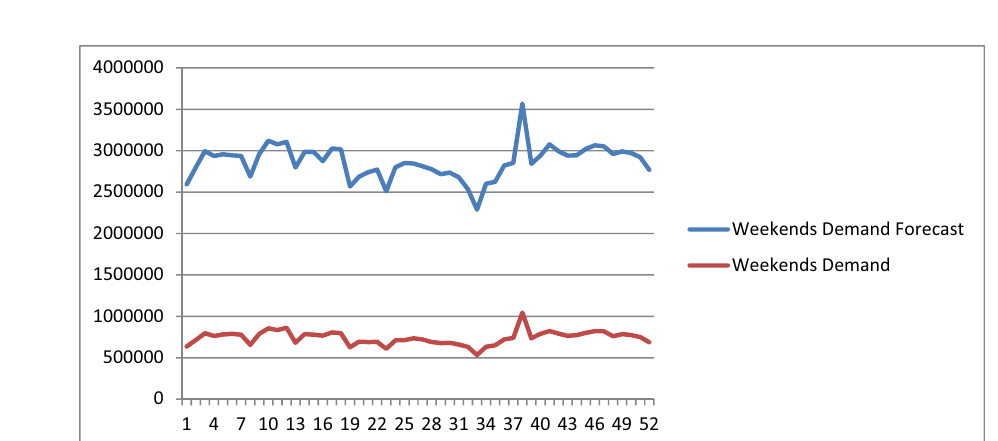
Figure 3: Comparison of regression analysis results and test values for